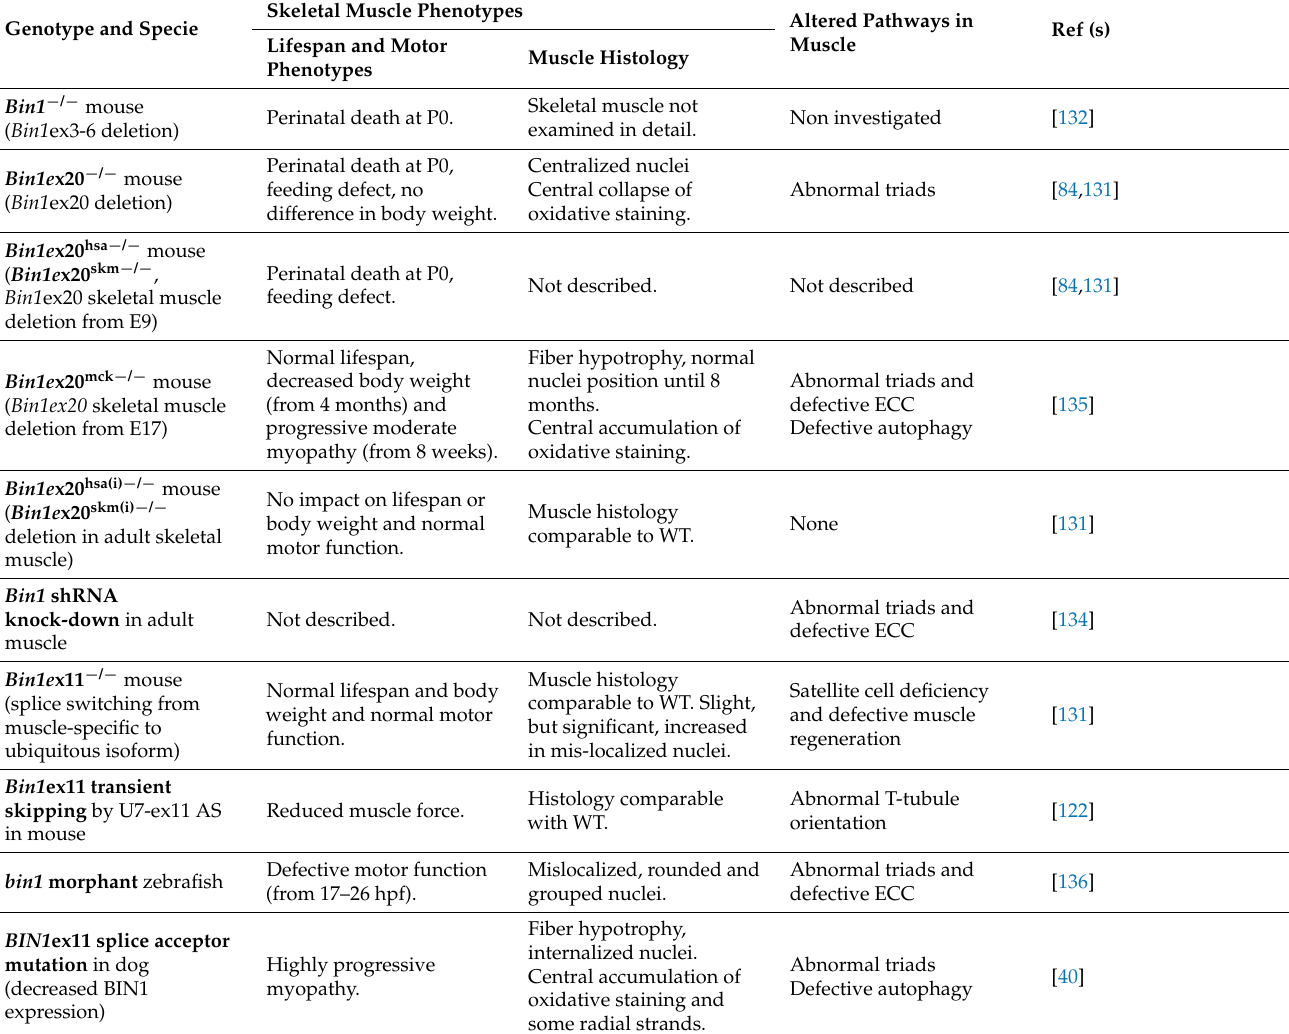
Table 4. Main fish and mammalian models for BIN1-related